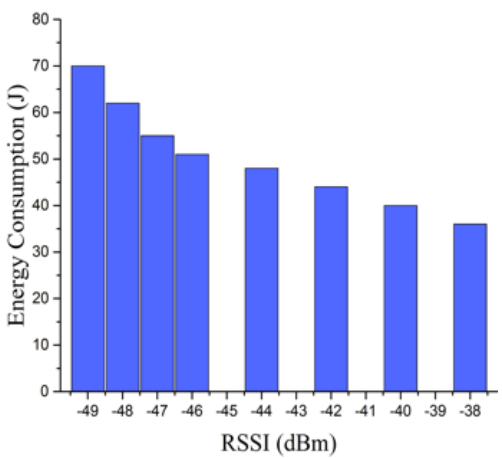
Figure 3. Energy consumption in 30 s vs. RSSI.